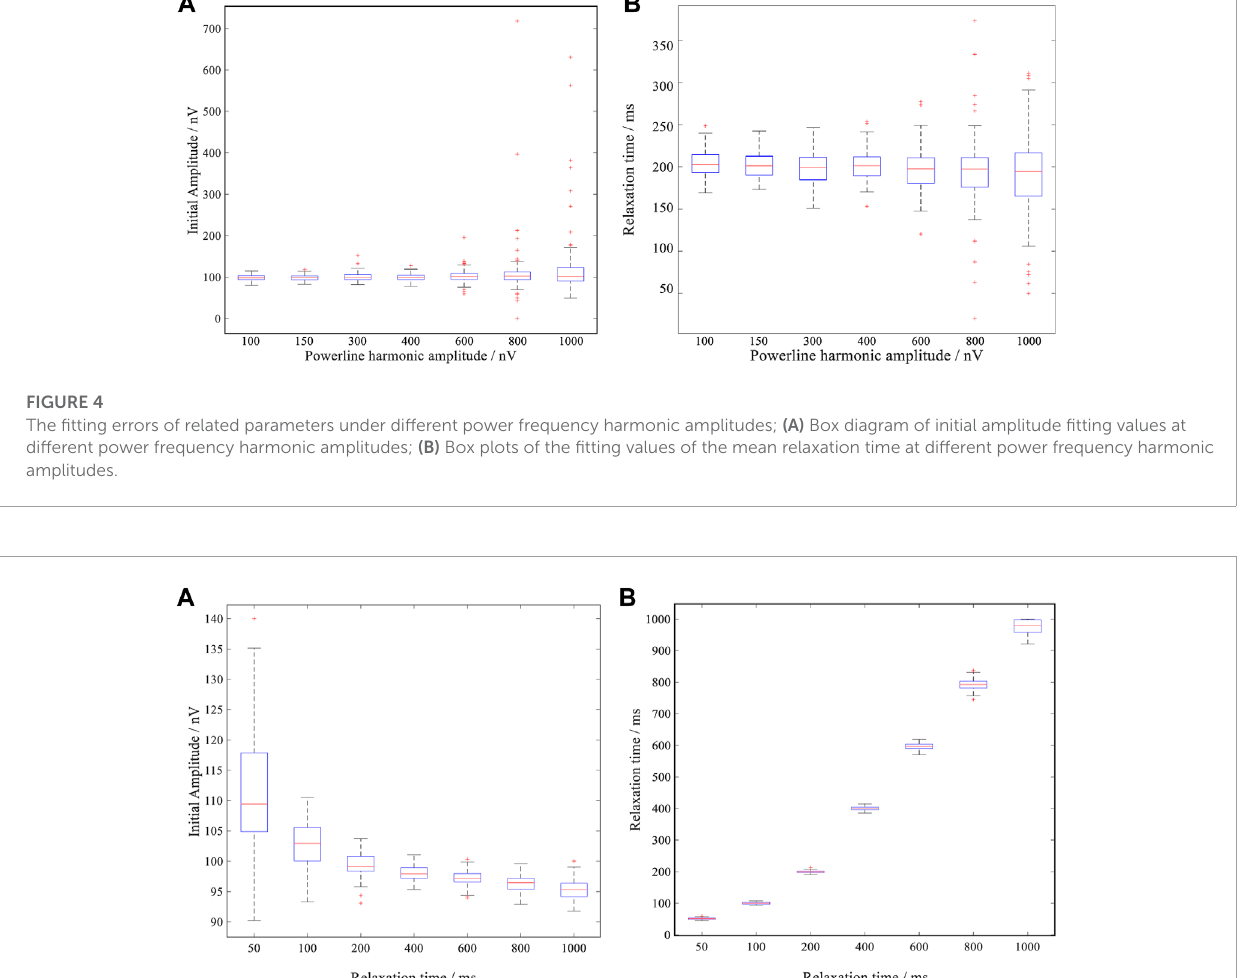
FIGURE 5 The fitting errors of related parameters under different relaxation times; (A) Boxplot of initial amplitude fitting values at different relaxation times; (B) Boxplot of relaxation time fitting values for different relaxation times.